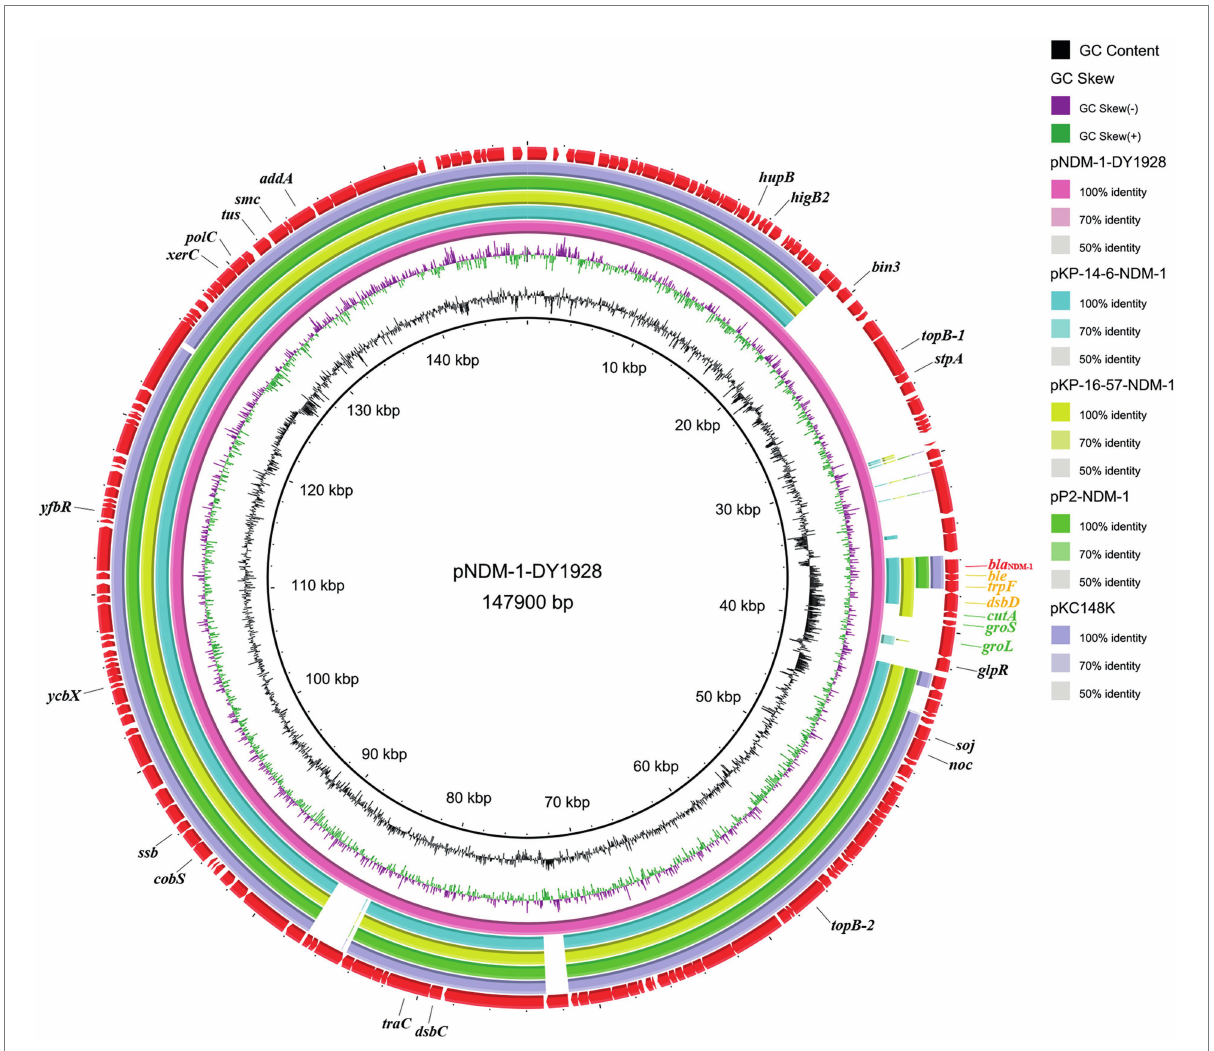
FIGURE 1 Genome comparison of pNDM-1-DY1928. A comparison of the plasmid pNDM-1-DY1928 sequence with four other plasmids harboring bla NDM-1 is shown in the figure. This figure was generated by